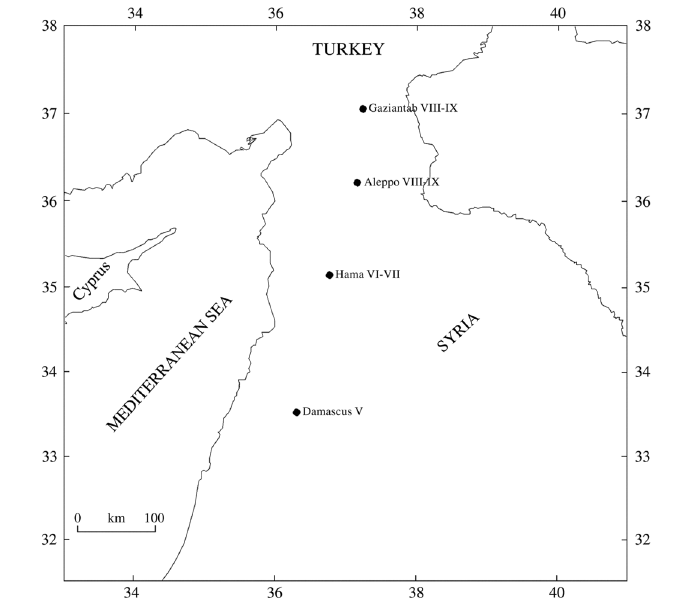
Fig. 11. Map of intensity distribution for January 21, 1626